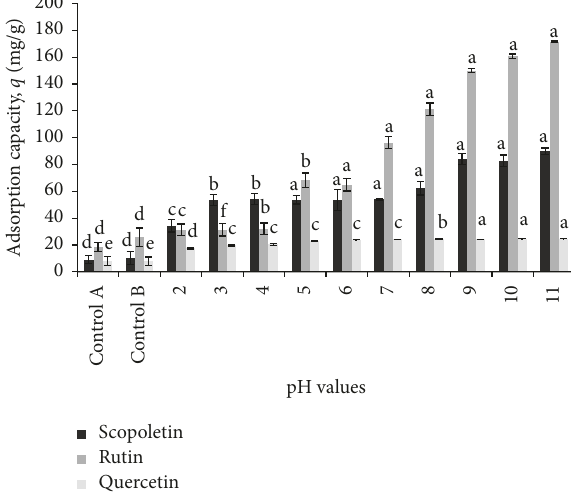
Figure 4: Effect of pH of phenolic compounds (scopoletin, rutin, and quercetin) adsorption in noni juice onto a weak base ion exchange resin (Amberlite IRA 67) at different pH. Graph rep- resents the mean of three replicate samples with error bars. Different letters in the same phenolic compounds indicate sig- nificant difference ( p 0 . ∗ <